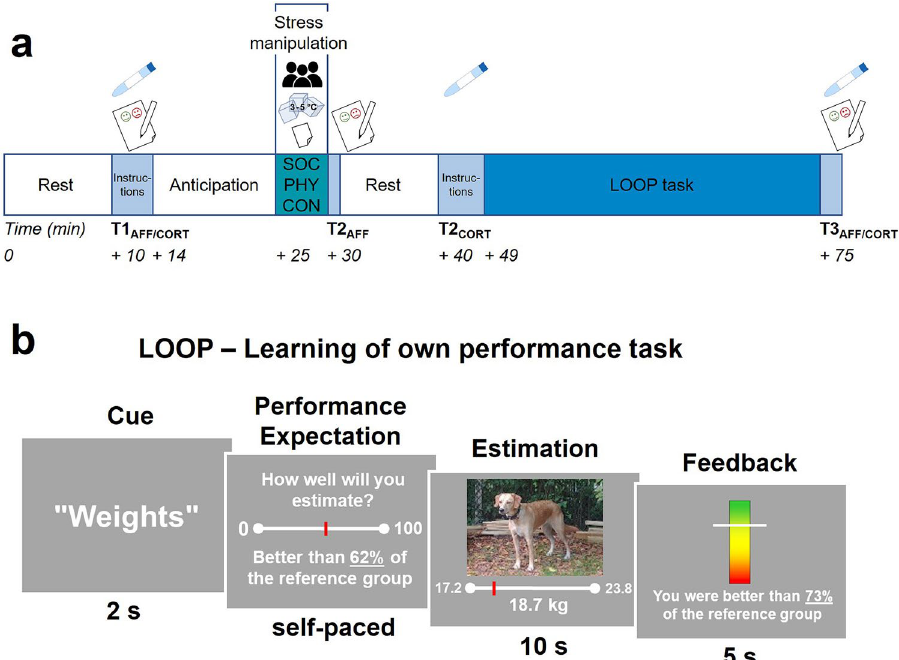
Figure 1. ( a ) Experimental timeline and procedure. SOC: social-evaluative stress group (public speech [audience icon], n = 29), PHY: physical stress group (Cold Pressor Test [ice cubes icon], n = 30), CON: no stress control group (reading task [paper icon], n = 30), salivette icon: saliva collection for cortisol determination; paper pencil icon: rating of negative affect including perceived stress, embarrassment, anger, and frustration. ( b ) Sequence of one trial. 1. Cue: display of the upcoming estimation category associated with a high or low ability condition, 2. Performance expectation rating, 3. Estimation question, 4. Performance feedback. Figure adapted from Müller-Pinzler et al. 21